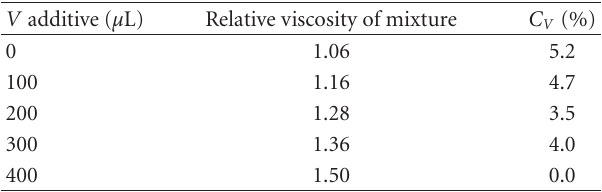
Table 2: Dependence of viscosity on the volume of thickening additive at 20 ◦ C (mean and coe ffi cient of variation for n = 5). V additive ( µ